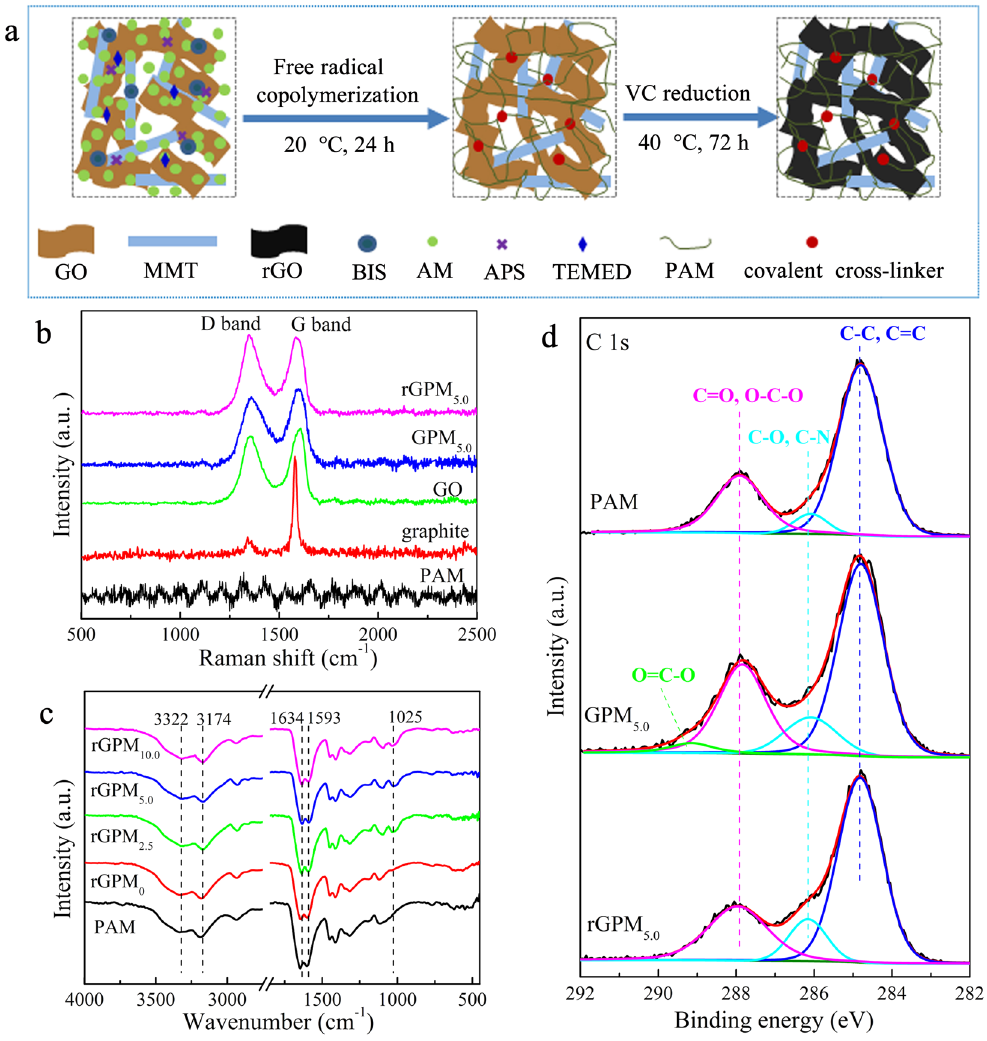
Figure 2. Schematic illustration of the preparation of rGPM n hydrogels ( a ); Raman spectra of PAM, graphite, GO, GPM 5.0 and rGPM 5.0 ( b ); FT-IR spectra of PAM and rGPM with different content of MMT ( c ); C 1s XPS spectra of PAM, GPM 5.0 and rGPM 5.0 ( d